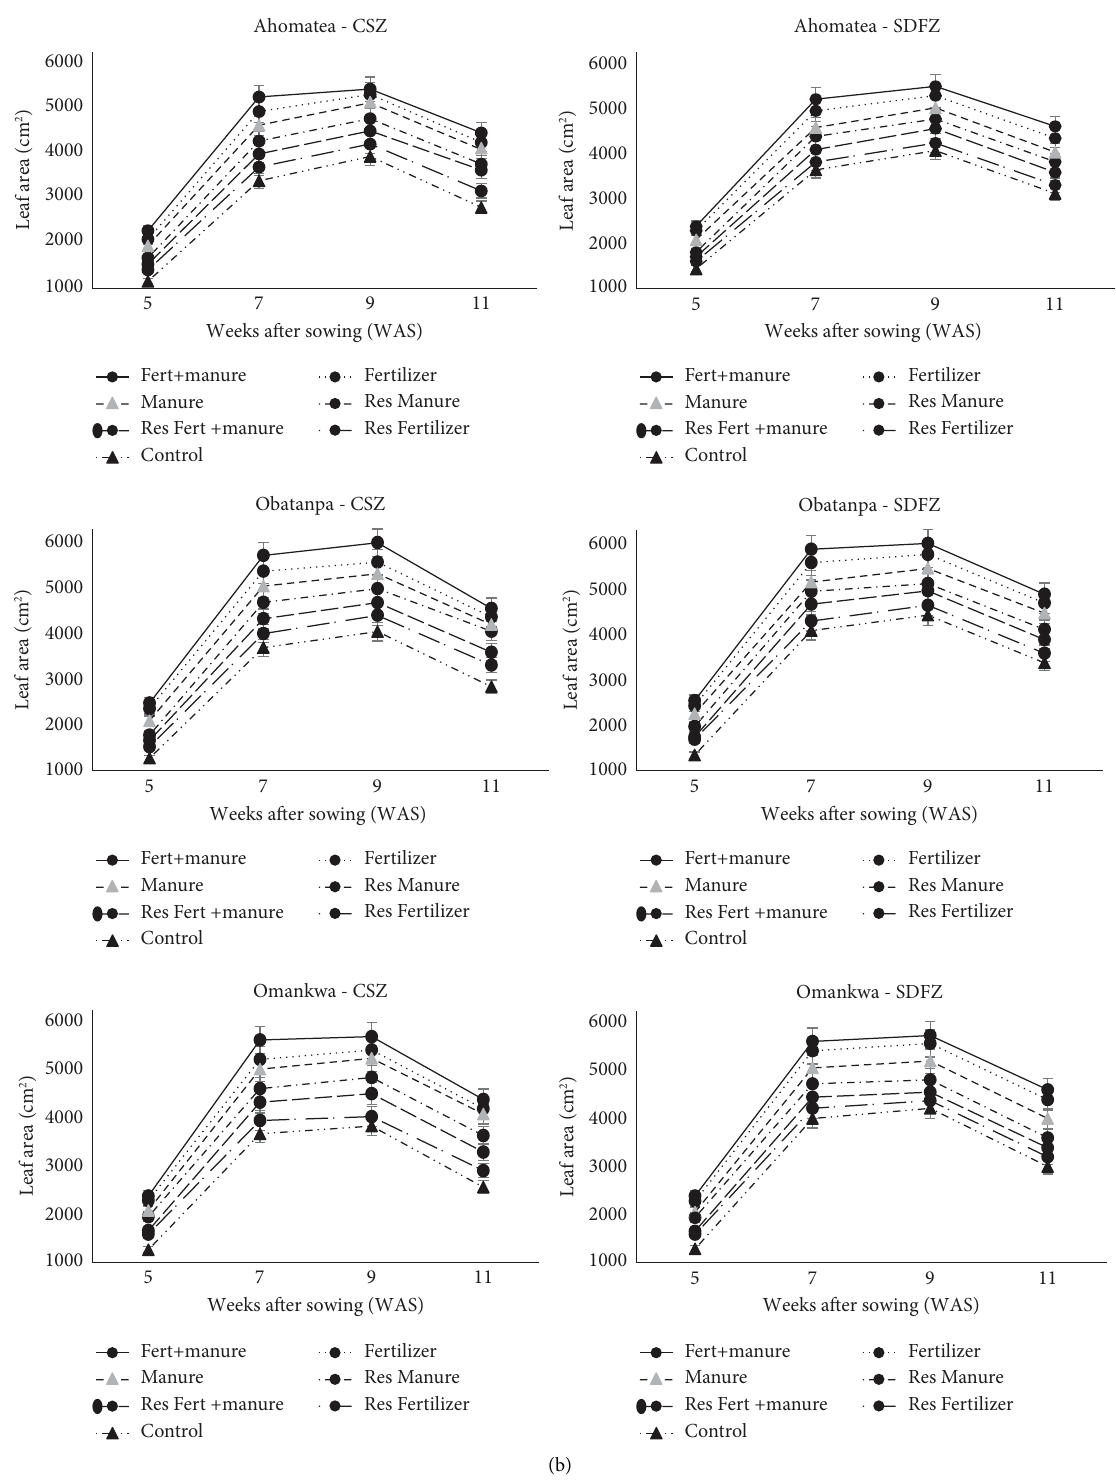
Figure 3: (a) Leaf area of Ahomatea, Obatanpa, and Omankwa maize varieties at 5, 7, 9, and 11 weeks after sowing (WAS) under diferent soil amendments in the coastal savannah (CSZ) and semi deciduous forest (SDFZ) zones of Ghana during the 2017 major cropping season. (b) Leaf area of Ahomatea, Obatanpa, and Omankwa maize varieties at 5, 7, 9, and 11 weeks after sowing (WAS) under diferent soil amendments in the coastal savannah (CSZ) and semi-deciduous forest (SDFZ) zones of Ghana during the 2017 minor cropping